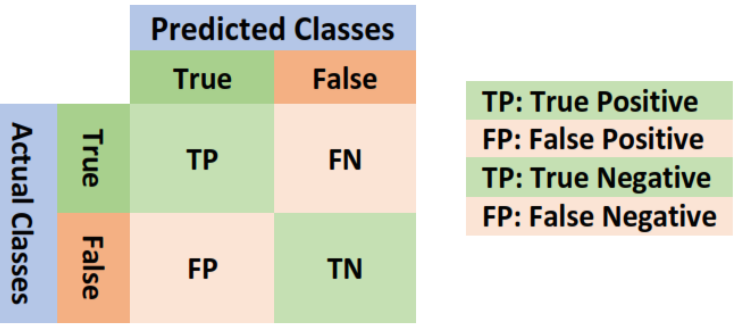
Figure 6. Description of confusion matrix .